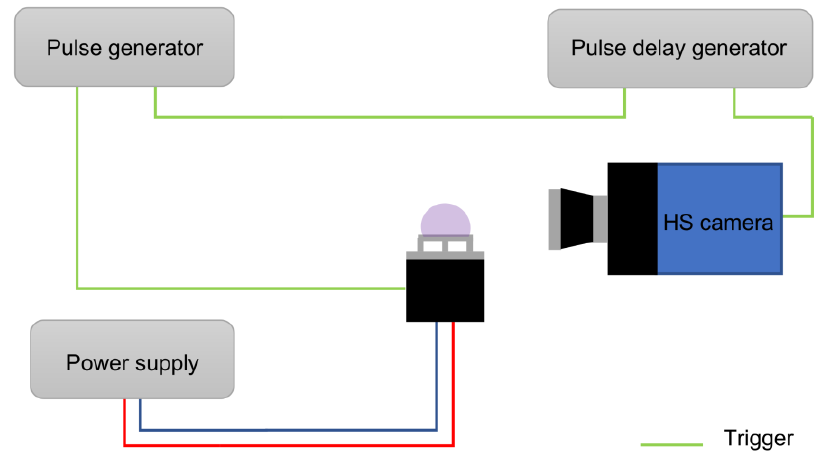
Figure 3. Schematic of the controlling and triggering system. The red and blue lines are the power supply and the green line is the trigger.